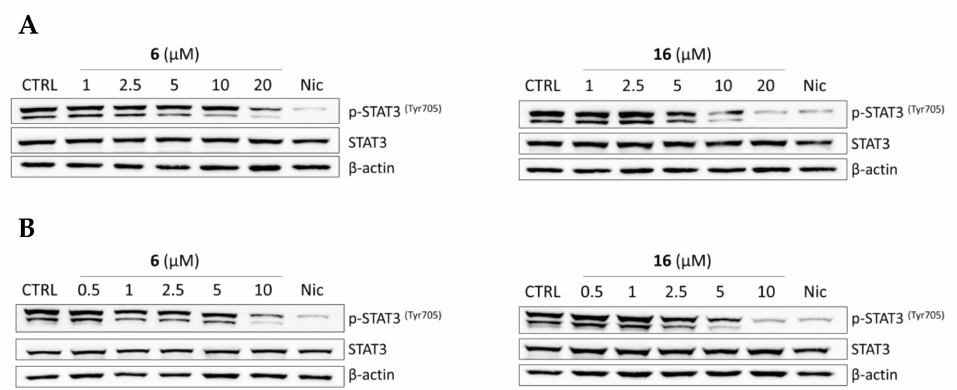
Figure 4. Compounds 6 and 16 reduced phosphorylation of STAT3 in human prostate cancer cells. DU145 cells were treated with both compounds at indicated concentrations for ( A ) 24 h and ( B ) 48 h. The levels of STAT3 and its phosphorylated form (p-STAT3 Tyr705 ) were detected by im- munoblot analysis using appropriate antibodies. Samples treated with 5 µ M of niclosamide (Nic) for 24 h and 48 h were used as positive controls. Representative immunoblots of one out of three experiments are shown. CTRL, drug-free